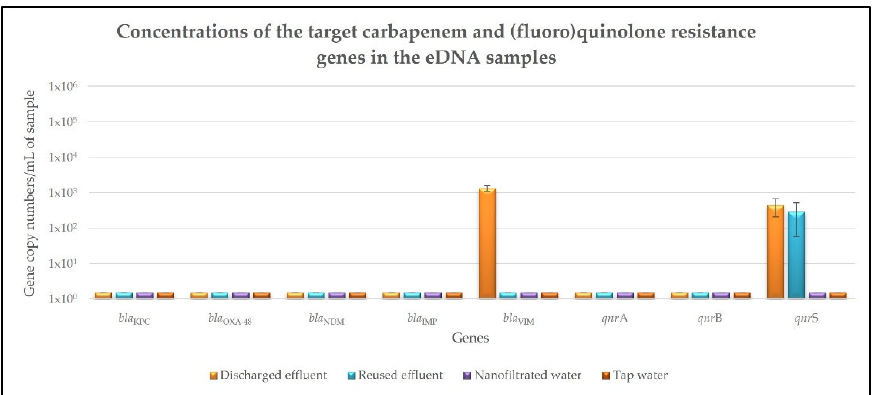
Figure 3. Concentrations of the target carbapenem and (fluoro)quinolone resistance genes in the eDNA precipitated and purified from the discharged effluent, reused effluent, nanofiltered water and tap water samples. Values are expressed in gene copy numbers per milliliter and correspond to the mean ± standard deviation of biological and technical triplicates.